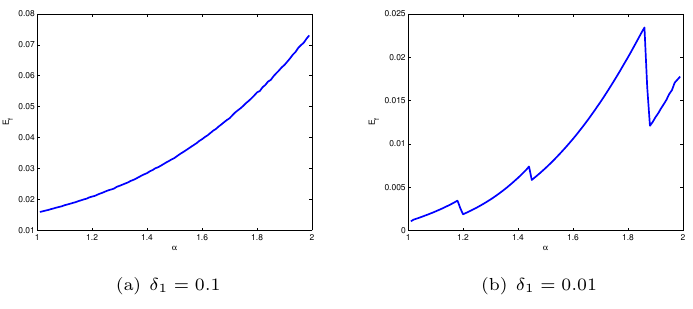
Figure 2. The variation of E f with α (Example